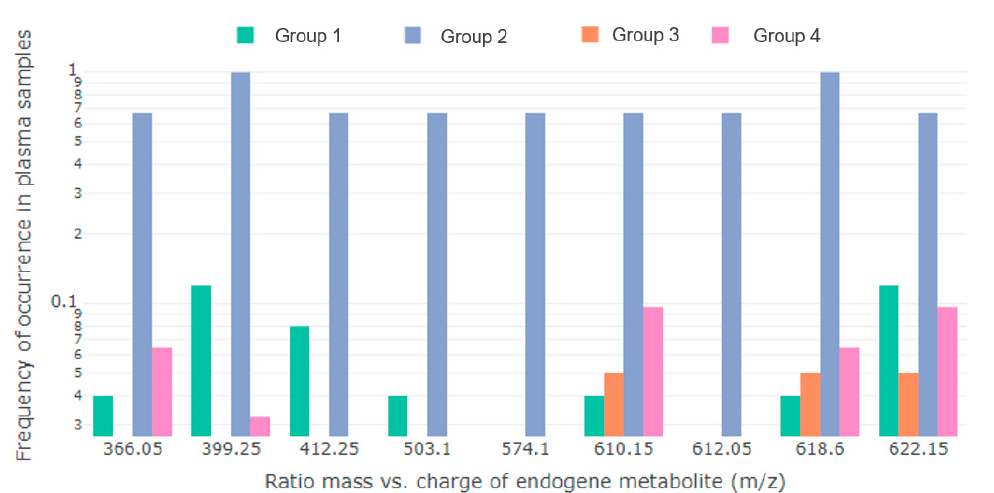
Figure 1. Frequencies (log scale) of nine m/z characteristics among four groups of patients without averaging over technical repetitions (TR). TR were considered as independent measurements. Group 1 and 2—a series of blood samples from patients in the control group and with developed PE, examined in the first trimester, respectively; Group 3 and 4—a series of blood samples from the study participants in the control group and with PE in the third trimester of pregnancy, respectively.